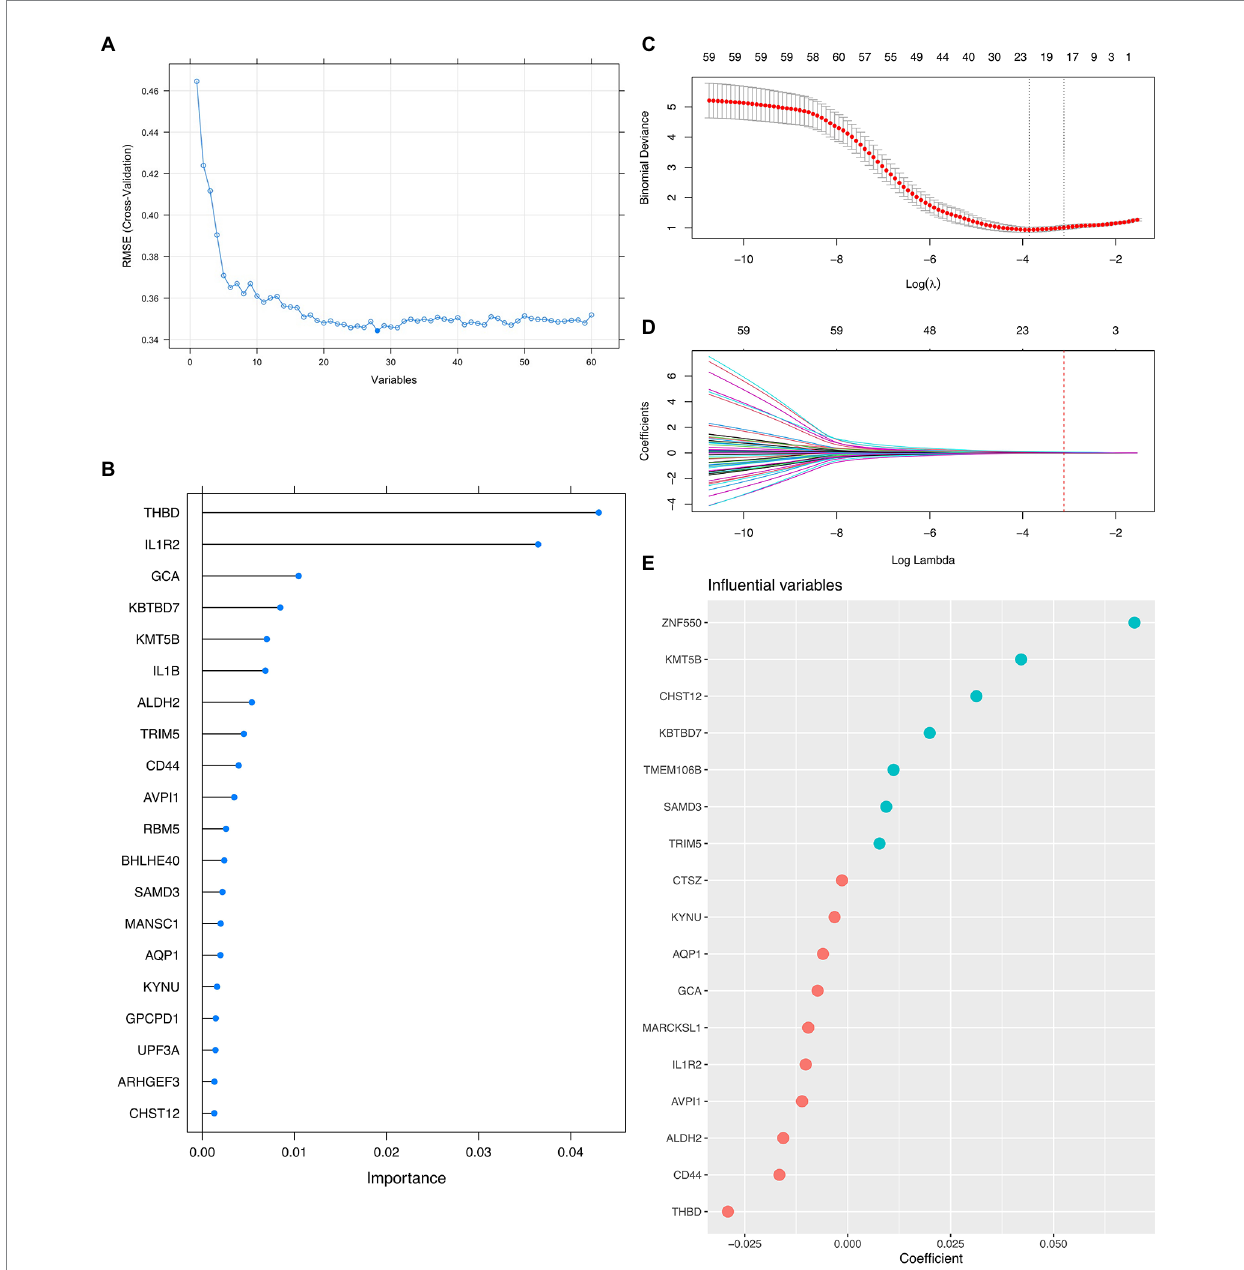
FIGURE 2 Integrative Approach for Feature Genes Selection. (A) Scree plot demonstrating the fluctuation of the RMSE value against the number of variants (i.e., feature genes) involved in formal modeling. (B) Lollipop plot shows each top 20 feature gene’s importance by the Random Forest algorithm. (C,D) Dot plots and curves demonstrate the binormal deviance changes and coefficient allocation process against the value of Log Lambda, respectively. (E) Bubble plot showing the importance of each top 20 feature genes by